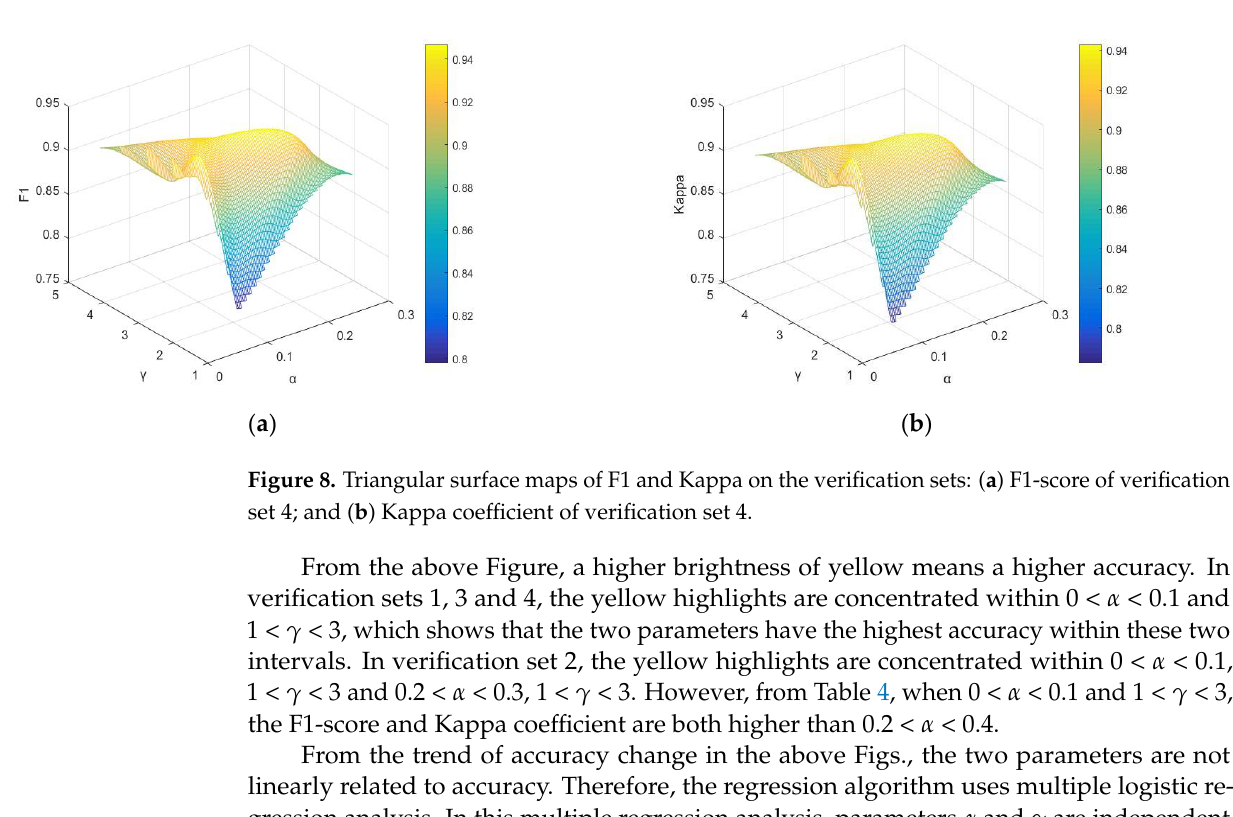
Figure 7. Triangular surface maps of F1 and Kappa on the verification sets: ( a ) F1-score of verifica- tion set 3; and ( b ) Kappa coefficient of verification set 3.